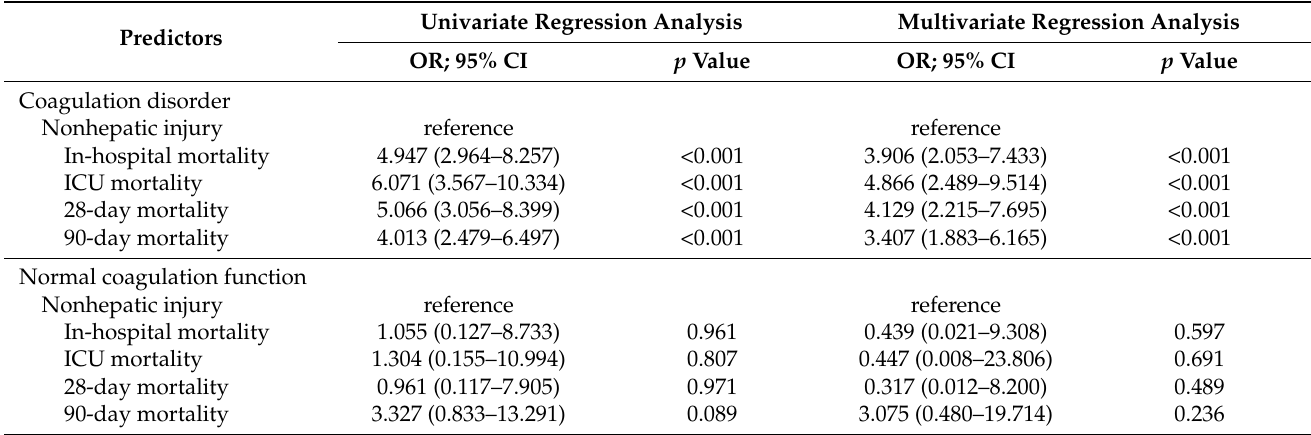
Table 3. Multivariate Regression of acute hepatic injury related to outcomes stratified by coagulation